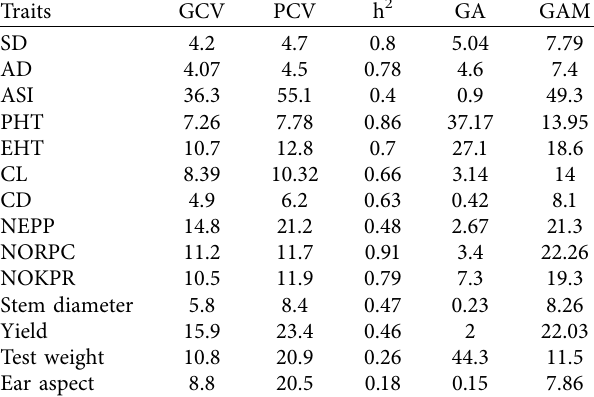
Table 10: Estimation of the genetic parameter of yield and yield-attributing traits of